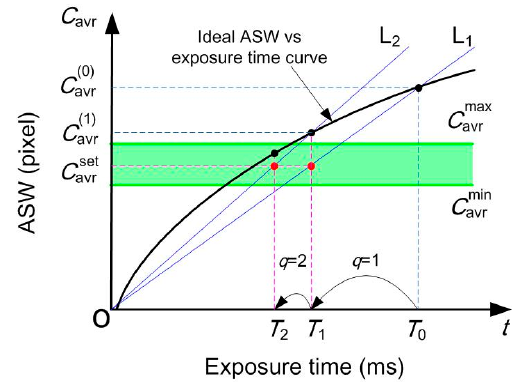
Figure 7. Computation principle of the linear iteration method.